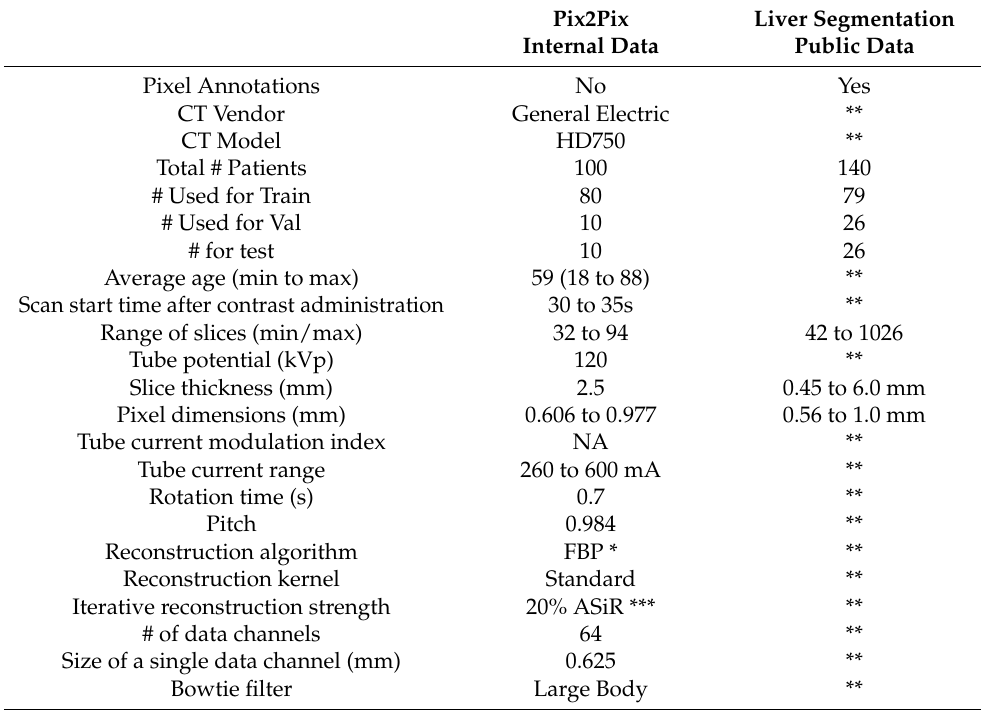
Table 1. Scan parameters and patient-specific characteristics for the datasets used to train the Pix2Pix system and then the semantic segmentation